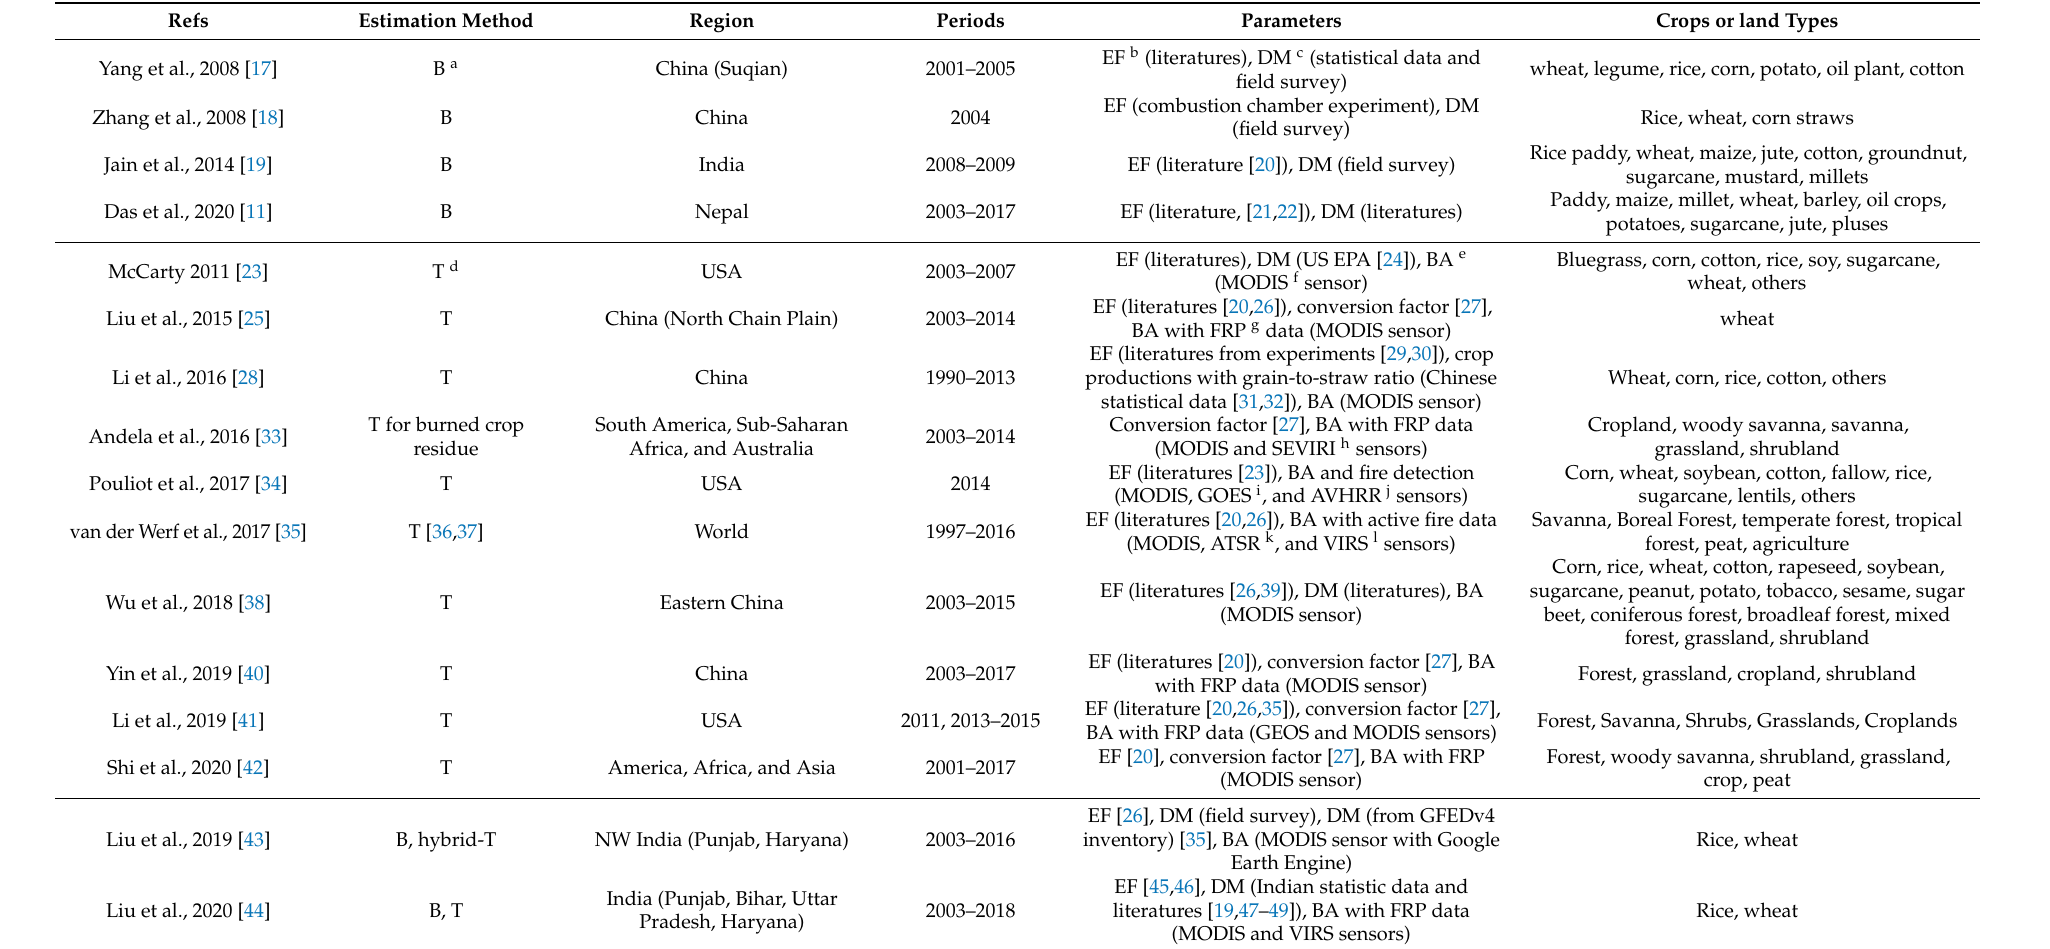
Table 1. Several studies on the estimation of biomass burning